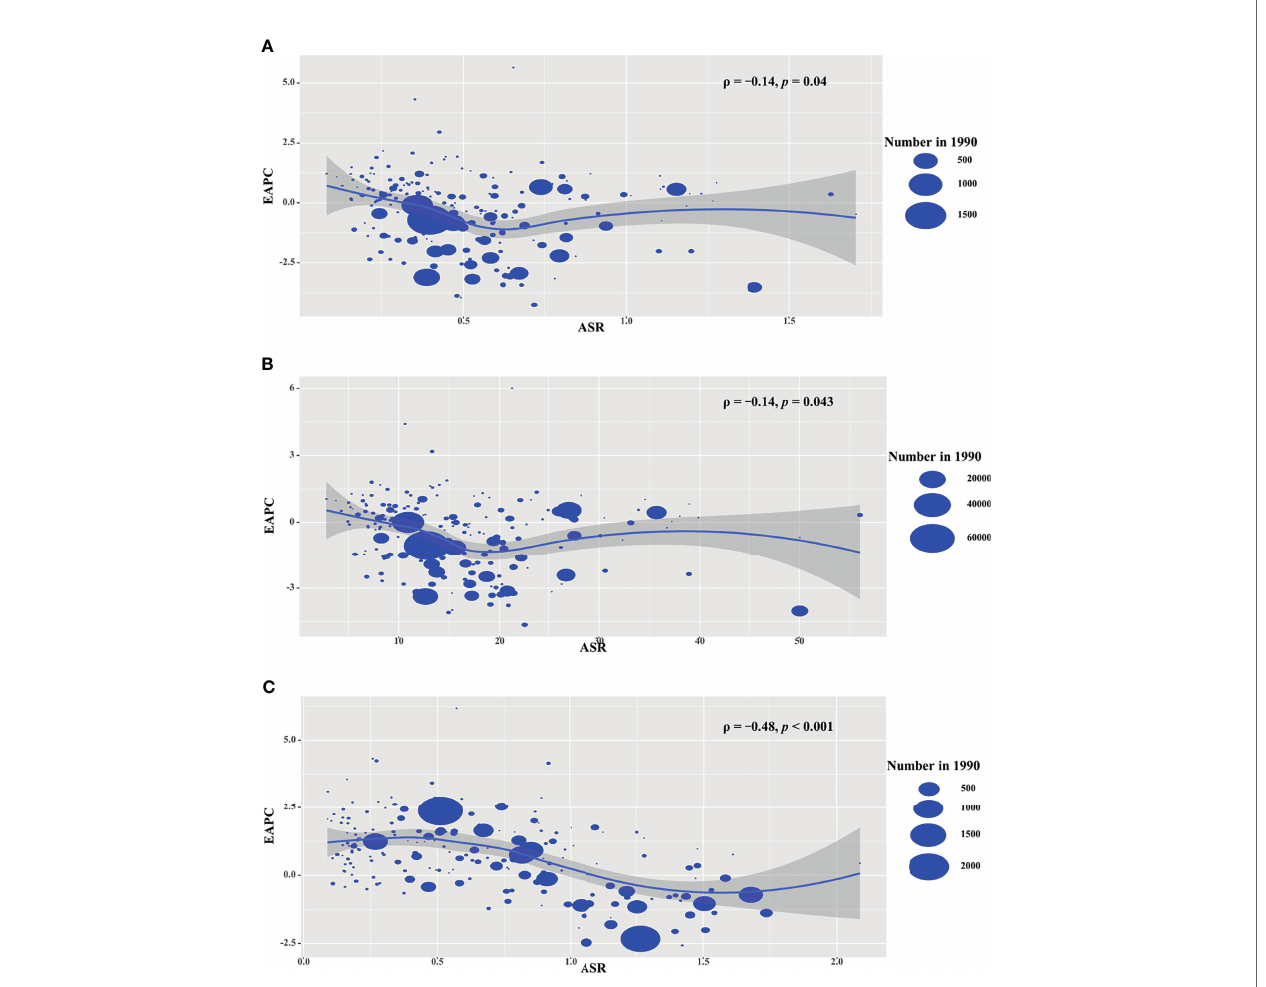
FIGURE 5 | Correlation analysis between EAPCs and ASRs in 1990 among countries. The ASRs of death (A) , YLLs (B) , and YLDs (C) had negative correlations with ASR, respectively. The correlations were calculated with Pearson correlation analysis. The symbols were the countries/territories in the corresponding regions. ASR, age-standardized rate; YLLs, years of life lost; YLDs, years lived with